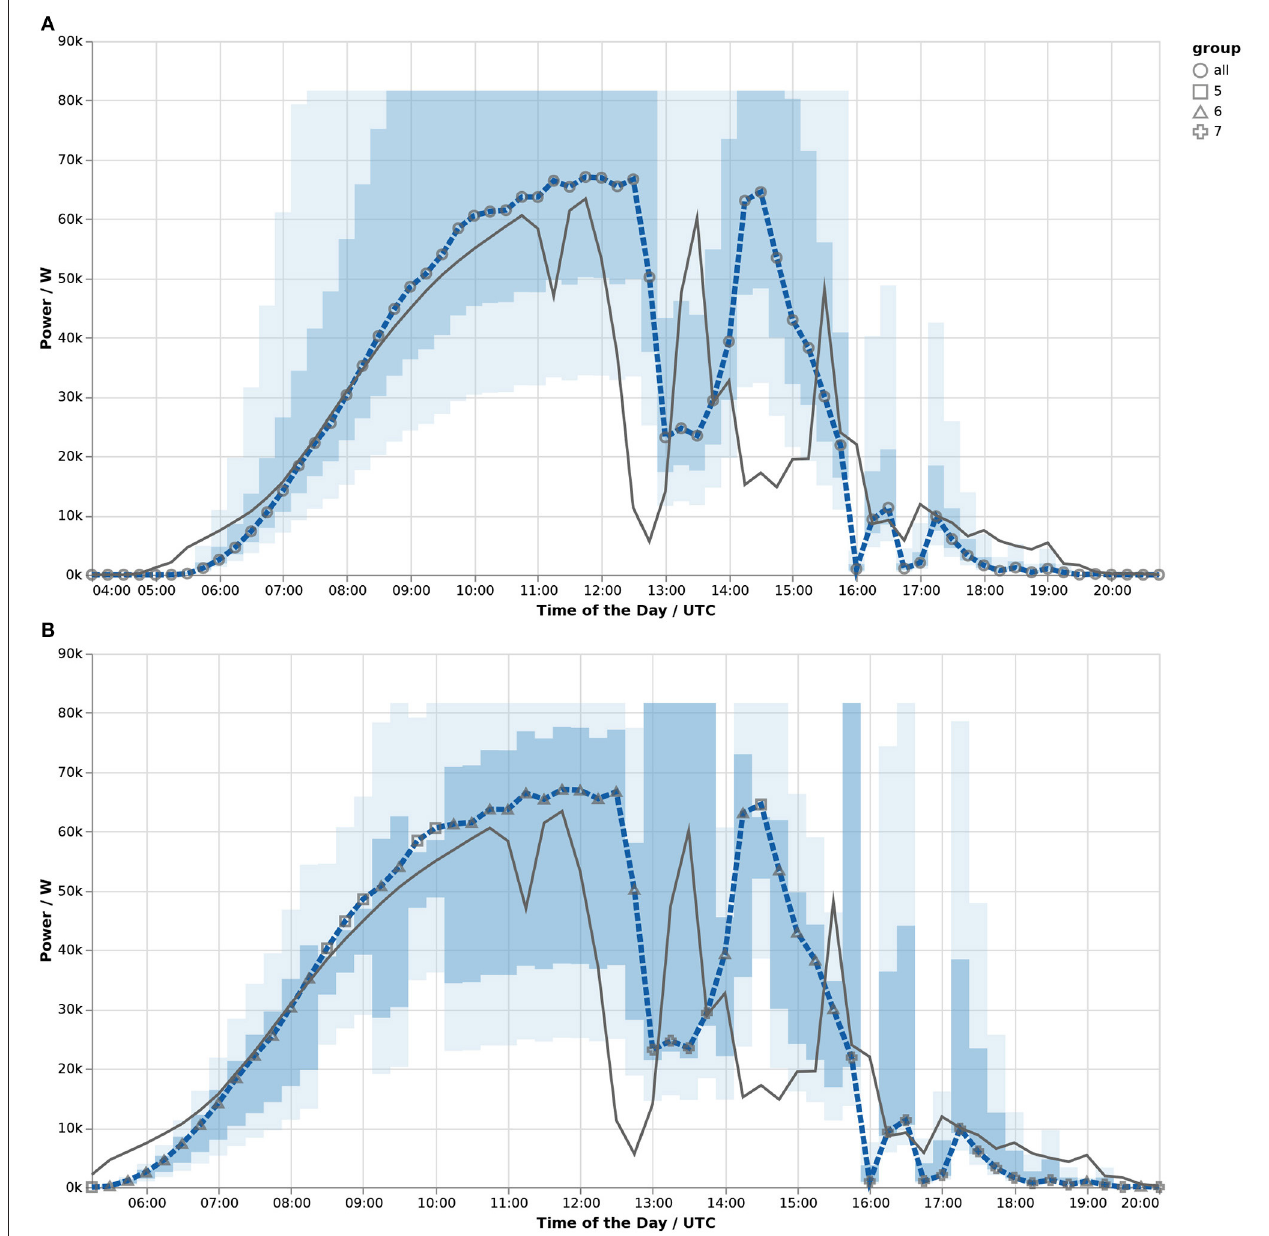
FIGURE 10 | Physics-based forecast, error bands and measured power for June 7, 2019; extent of the confidence band based on overall performance (A) and bins k c (B) of 1 −